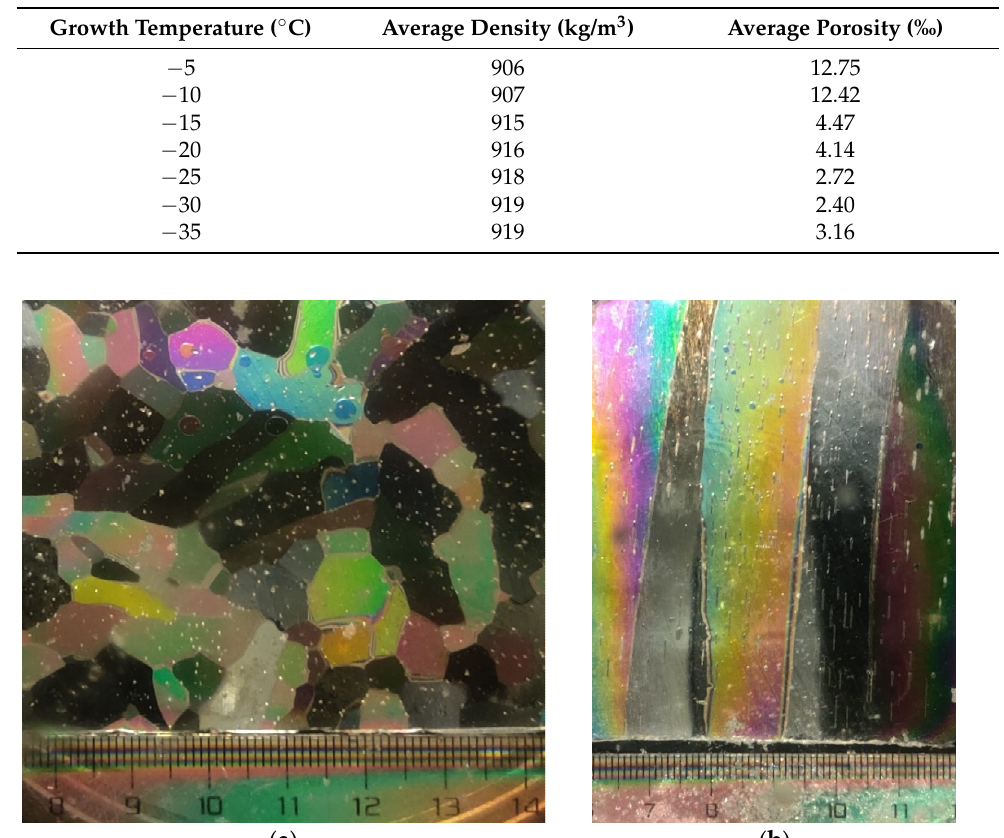
Figure 9. Thin sections of distilled water ice grown at − 15 °C photographed in polarized light. ( a ) is the horizontal section at the depth of 0 cm (top) and ( b ) is the vertical section of 8–16 cm.